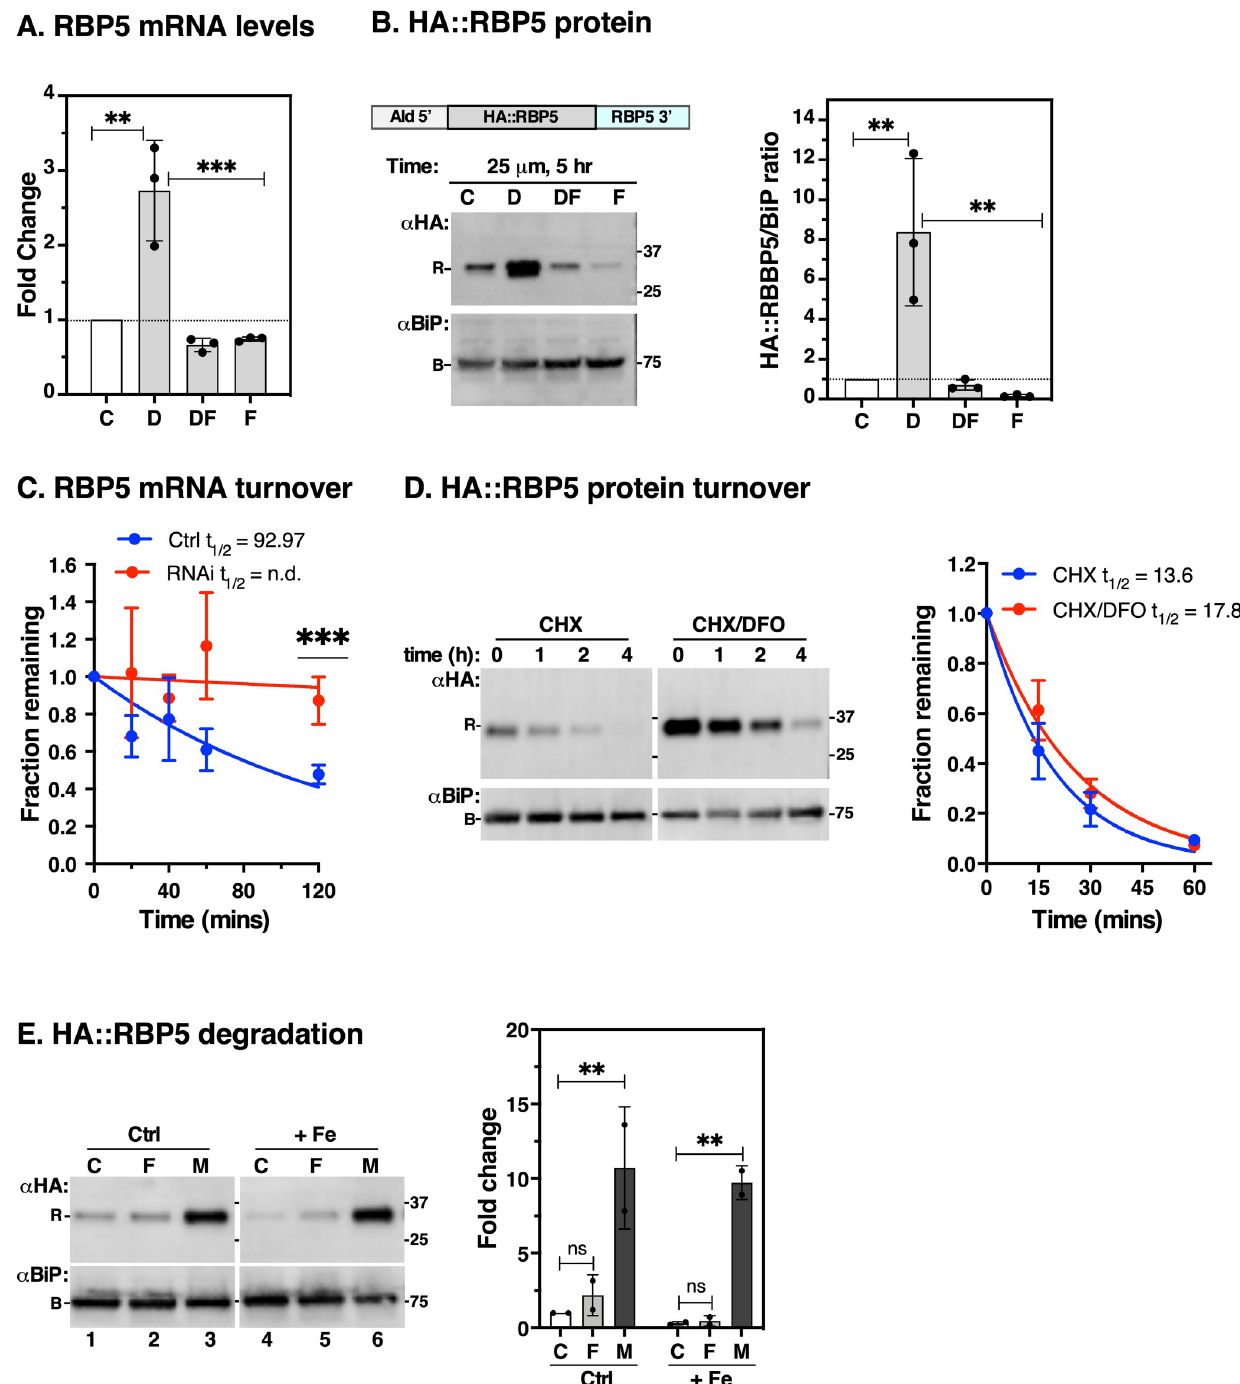
Fig 6. Effect of iron starvation on RBP5 stability. A . qRT-PCR analyses of endogenous RBP5 mRNA levels following treatment of wild type cells as described in Fig 1. Data are means ± SD ( n = 3 biological replicates; with 3 technical replicates for each n ). �� P < 0.002, ��� P < 0.001, as determined by one- way ANOVA with post-hoc Tukey test. Only statistical comparisons with p -values < 0.05 are displayed. All others are not significant. B . Schematic of N- terminal in situ tagged RBP5 (HA::RBP5) preserving its native 3’-UTR—see Supplementary S3 Fig HA::RBP5 cells were incubated with DFO as described above, total protein was immunoblotted with anti-HA (RBP5, R) or α BiP (B, loading control) antibodies. Bar chart (right) shows signals of HA::RBP5 from immunoblot quantified by densitometry using Image Lab software (Bio-Rad) normalised to the corresponding BiP signals relative to control samples. Data are means ± SD ( n = 3 biological replicates). C . Endogenous RBP5 mRNA turnover. The half-life of RBP5 was determined by qRT-PCR using cDNA samples derived from TfR knockdown (RNAi) or control (Ctrl) cells incubated with Sinefungin and Actinomycin D as described above. Data are